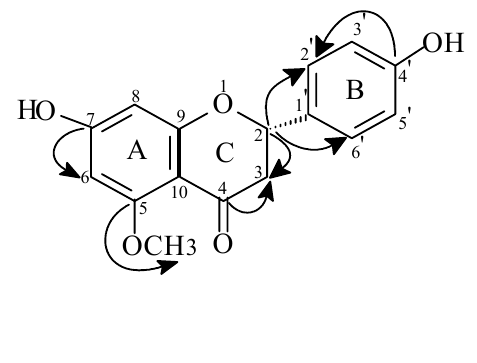
Figure 1. Heteronuclear multiple-bond correlations for 1 . Arrows point from carbon to